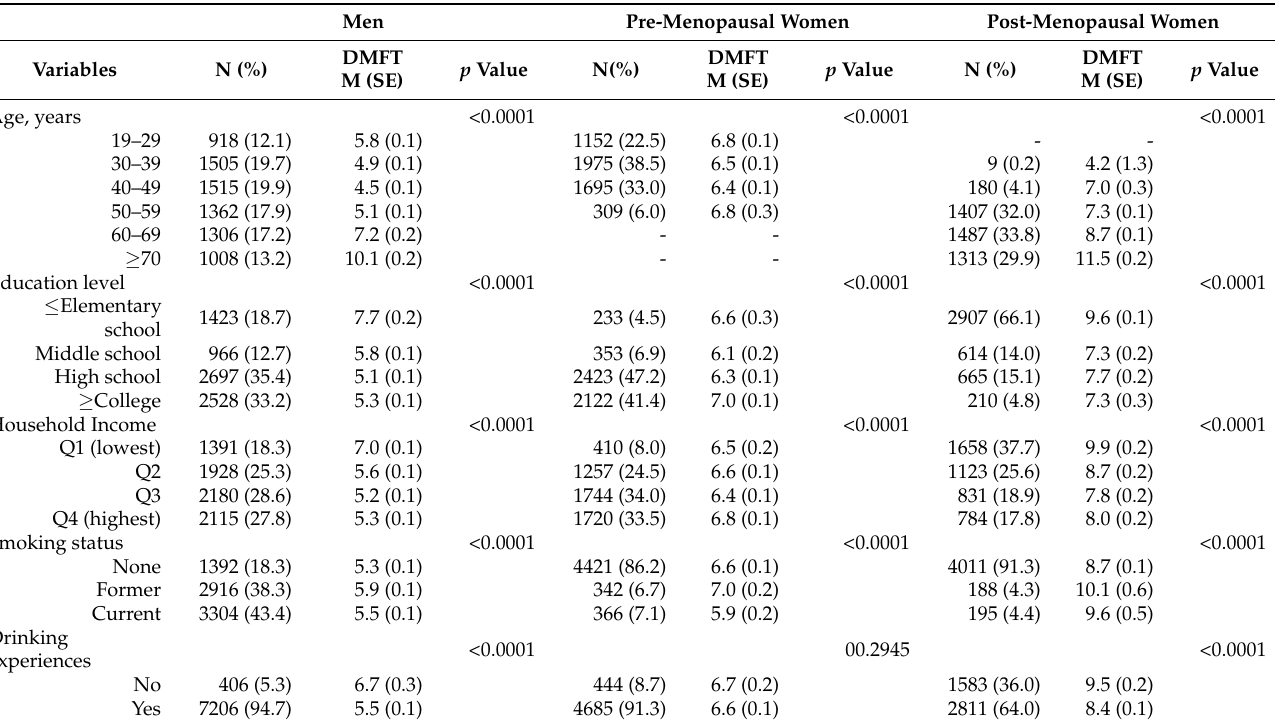
Table 1. Mean of DMFT index according to the general characteristics of the participants.